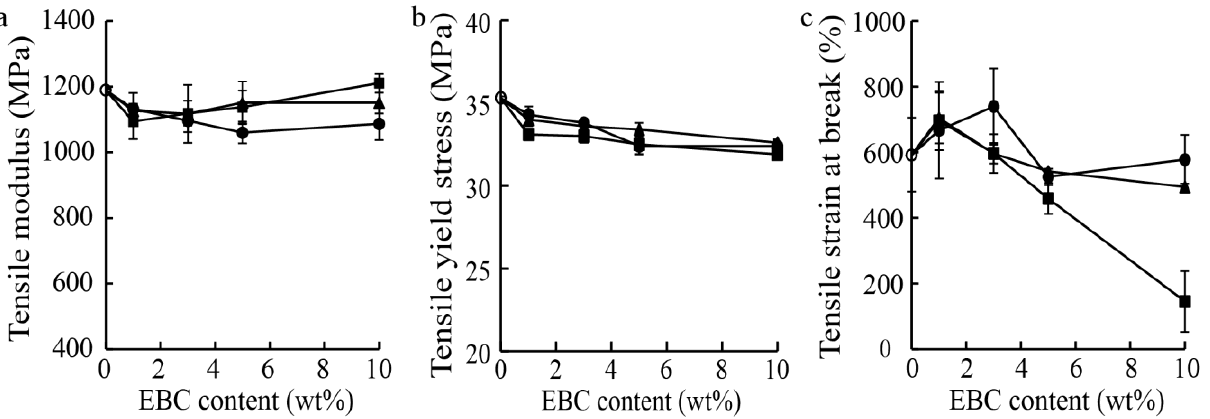
Figure 4. ( a ) Tensile moduli, ( b ) stresses and ( c ) strains at break of neat PP (○), the PP/EBC blends (●), and the LCNF (▲) and wood flour (■)